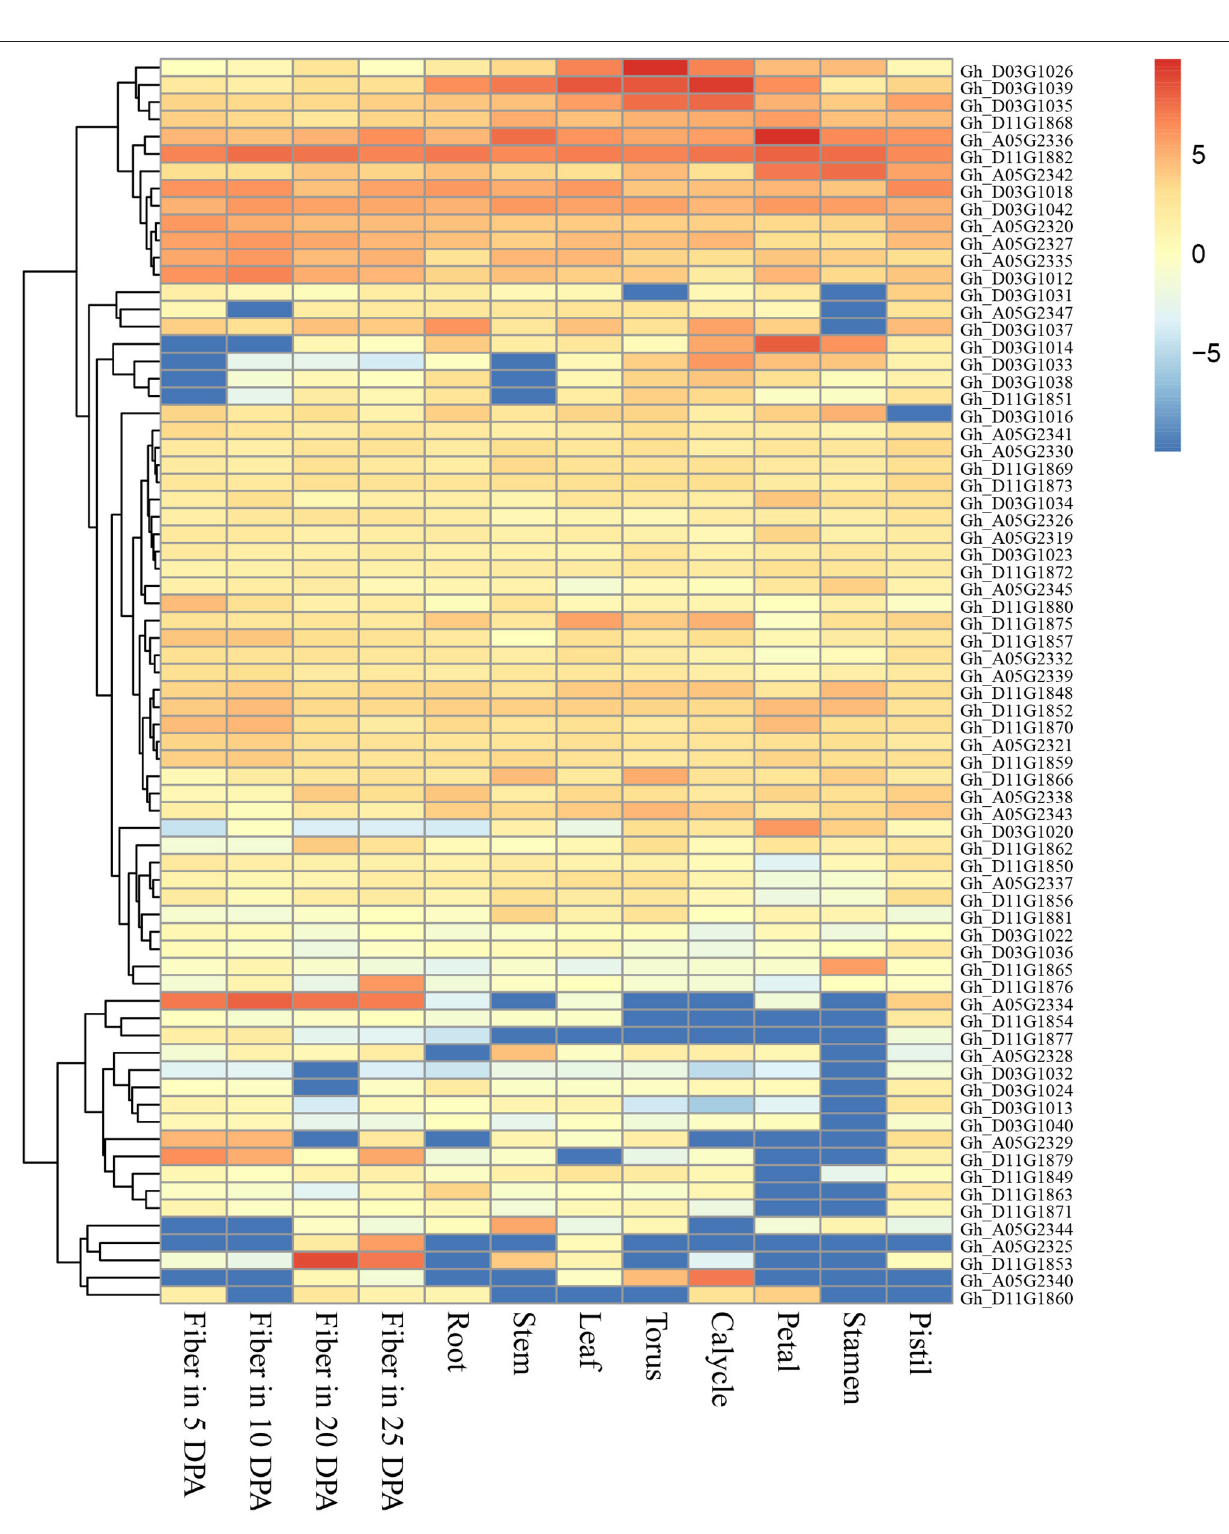
Frontiers in Plant Science |